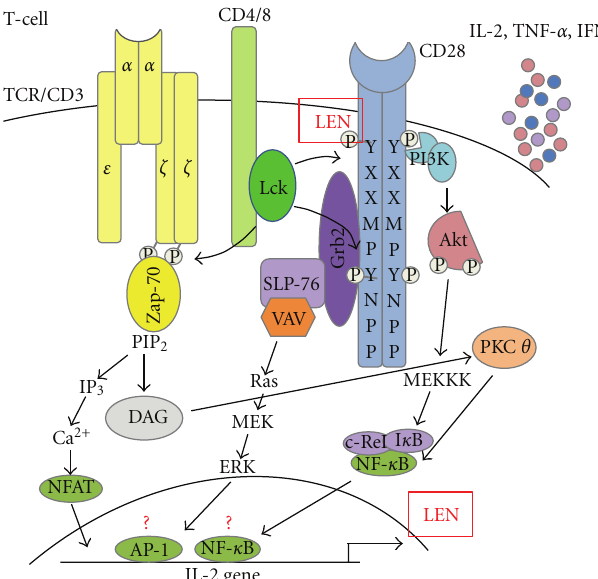
Figure 1: Various T-cell signaling pathways are upregulated after lenalidomide treatment. Lenalidomide is known to have no direct mitogenic activity, therefore it cannot induce proliferation directly. Upon TCR ligation, lenalidomide (LEN) increases phosphorylation of tyrosines within the intracytoplasmic tail of CD28, through an unknown mechanism, increasing downstream signaling and activation of PKC- θ , MAPK, and potentially other signaling pathways. These pathways lead to the activation of classic T-cell transcription factors like AP-1, NFAT-1, and NF- κ B that induce secretion of the T helper type 1 (Th-1) cytokines interleukin-2 (IL-2), tumor necrosis factor- α (TNF- α ), and interferon- γ (IFN- γ ). Though it is controversial which transcription factors are ultimately increased upon lenalidomide treatment (indicated by a question mark). Upregulation of these pathways potentially reverses T-cell defects, aids in breaking tolerance, and leads to greater CD4+ T-cell help to DCs, NK cells, and CD8+ T cells, augmenting eradication of the tumor